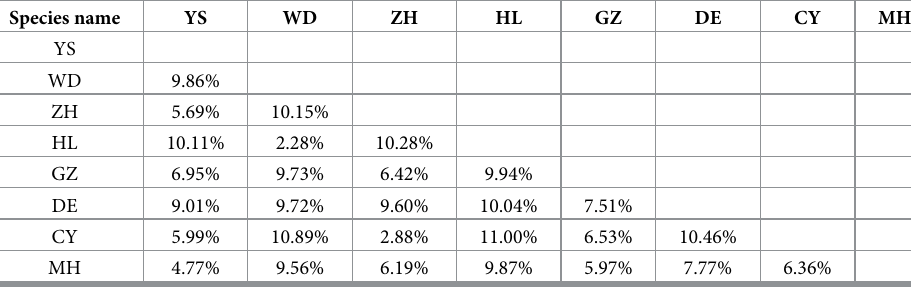
Table 5. Genetic distances among 8 species of Actinidia